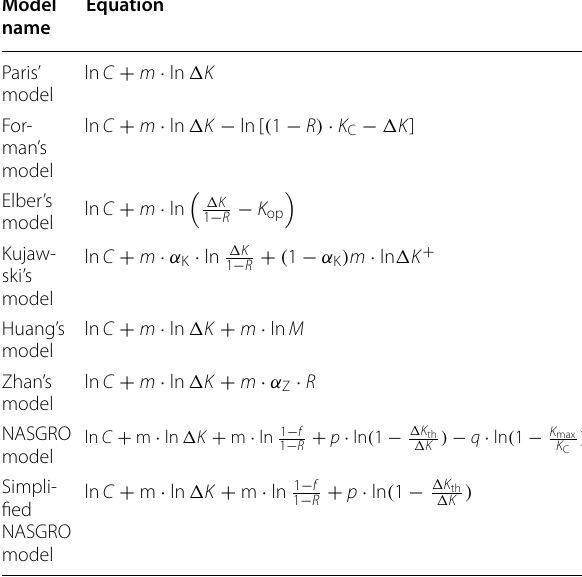
Table 1 Eight equations of traditional FCG rates prediction